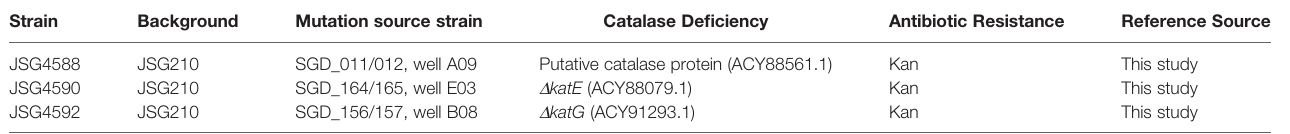
TABLE 2 | Catalase mutant strains used in this